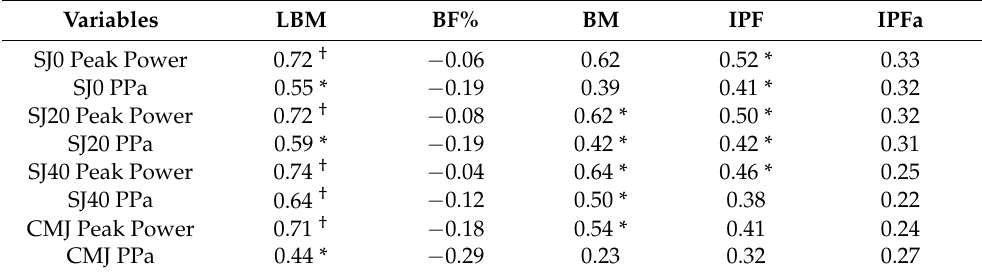
Table 3. Correlations between Body Composition, Maximum Strength, and Power